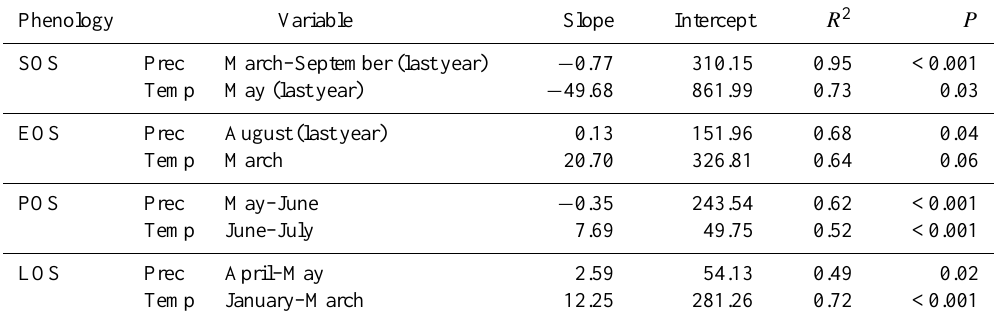
Table 4. The climate variables most strongly correlated with phenology, and the corresponding parameters of its linear model. SOS is the start of growing season; POS is the maximum NDVI date during the growing season; EOS is the date of the end of season; LOS is the length of growing season. Prec and Temp represent the precipitation and temperature,